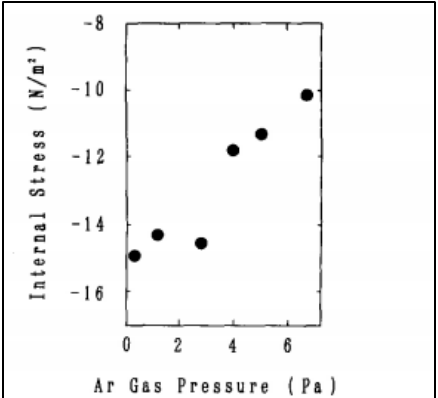
Figure 13. Dependence of the Internal Stresses in ZnO Layers on the Sputtering Gas Pressure [26].